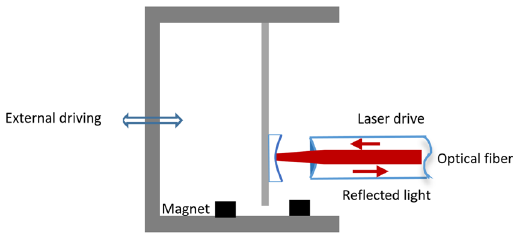
Figure 1. Schematic diagram of the proposed hybrid electro-optomechanical